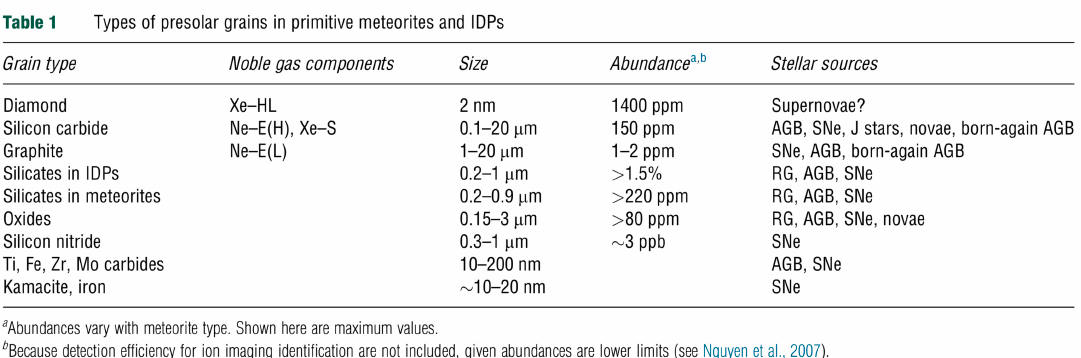
Figure 21. Types of presolar grains in primitive meteorites and interplanetary dust particles (IDPs) and their sizes, approximate abundances, and proposed stellar sources; from Reference